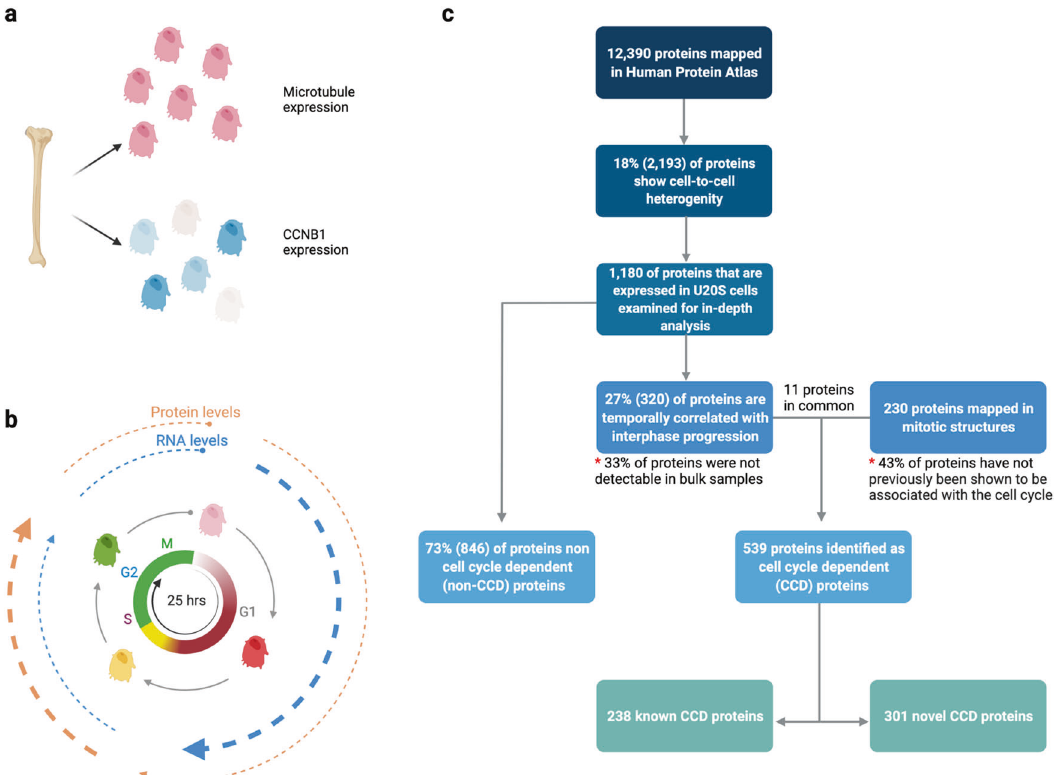
Fig. 1 Cell cycle regulates expression pro fi le of certain proteins. a Cell-to-cell variability in protein expression in U2OS cells exempli fi ed by the speci fi c cell-cycle-dependent (CCD) cyclin B1 (CCNB1), in blue, and homogenously expressed microtubules, in pink. b Fluorescent ubiquitination-based cell cycle indicator (FUCCI) system in U2OS cells: each cell temporarily expresses two fl uorescently tagged cell cycle markers (i) Chromatin Licensing and DNA Replication Factor 1 (CDT1) expressed in G1 phase and tagged with red fl uorescent protein (RFP) (ii) Gemini (GMNN) expressed during S and G2 phases and tagged with green fl uorescent protein (GFP). Both markers expressed in S-transition so yellow fl uorescent is detected. Most of CCD transcripts peak in expression during G1 phase, blue circle, while most CCD proteins peak during S and G2 phases, orange circle. c Flow chart summarizes the numbers and percentages of the proteins examined in the study. As a fi rst step, proteins that show cell-to-cell variability in terms of protein expression are selected from an open-access comprehensive resource of mapped 12,390 proteins, Human Protein Atlas. 18% of all proteins show cell-to-cell variability. Two hundred and thirty of these proteins localize to mitotic structures in U2OS cells. Thousand one hundred and eighty proteins displaying cell-to-cell variability were further characterized using the FUCCI system, so a group of 320 proteins whose expression levels are correlated with cell cycle progression is identi fi ed. The 230 proteins whose expression correlates with the cell cycle progression are summed up with the ones expressed in mitotic structures and are called cell cycle dependent (CCD) proteins. Out of 539 CCD proteins, 238 have been studied and 301 have not been associated with cell cycle progression, they were named “ known CCD ” and “ novel CCD ” proteins, respectively. Eight hundred and forty-six proteins that are not correlated with the cell cycle are non-CCD proteins. Text labeled with asterisks indicates the state of the art resulting from studies using the FUCCI system and imaging techniques. Created with